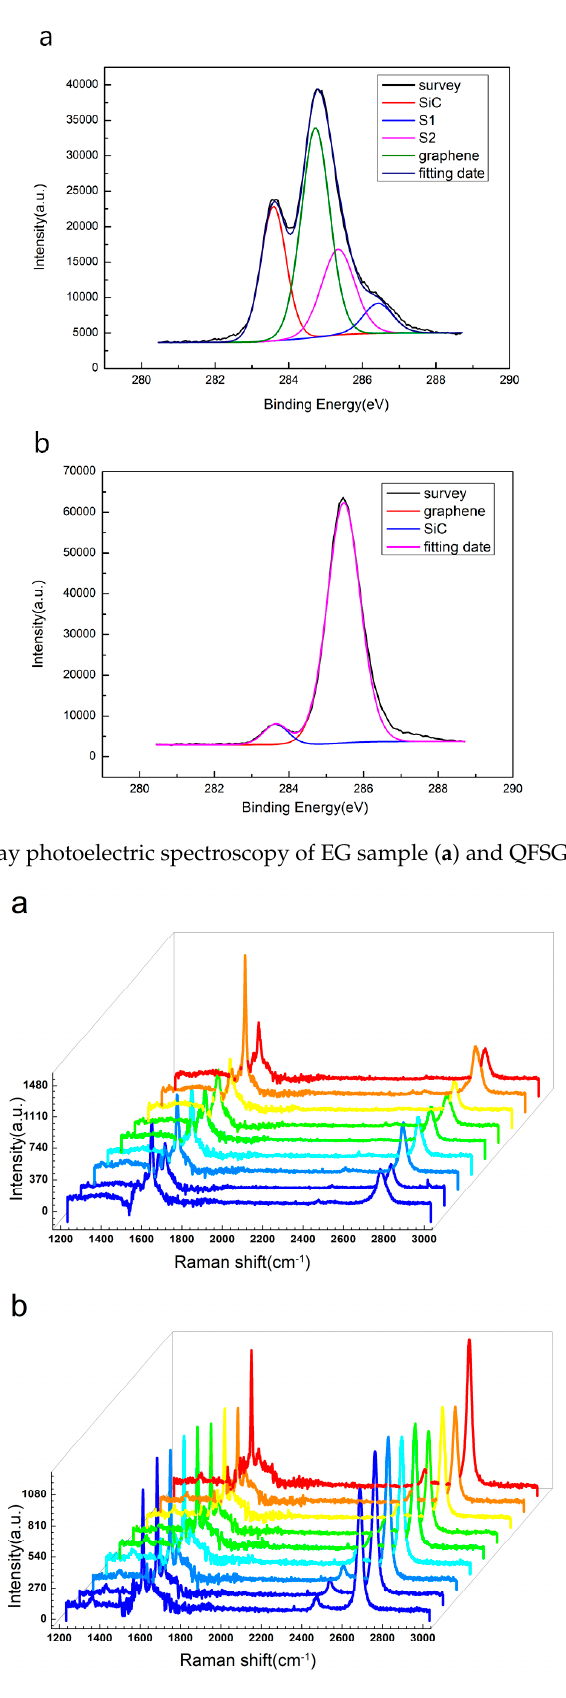
Figure 4. Raman spectra at nine random points on the surface of EG sample ( a ) and QFSG sample ( b ).